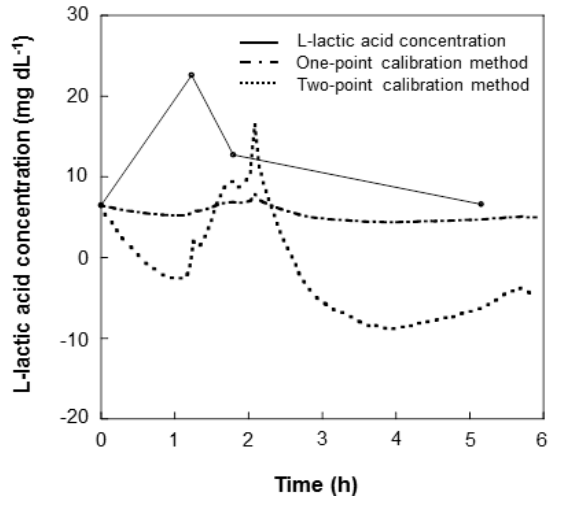
Figure 8. Relationship between L -lactic acid concentration in EISF and the calibrated sensor response. The L -lactic acid concentrations are plotted as circles, the calibrated response using the one-point calibration method is plotted as a broken line, and the calibrated response using the two-point calibration method is plotted as a solid